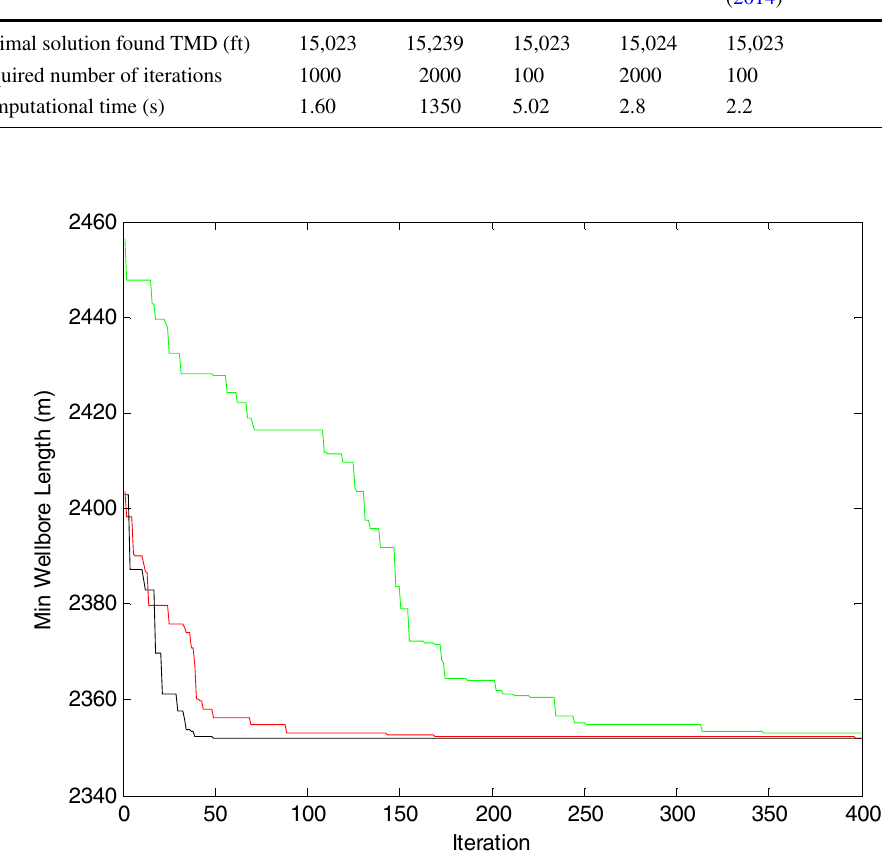
Table 8 Comparison of the best results achieved by each tuned metaheuristic algorithms applied to the wellbore optimization Case 1 GA Optimal solution found TMD